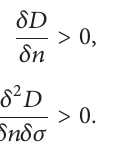
Figure 7: Load region and its strengthening and damaging effect (adapted from